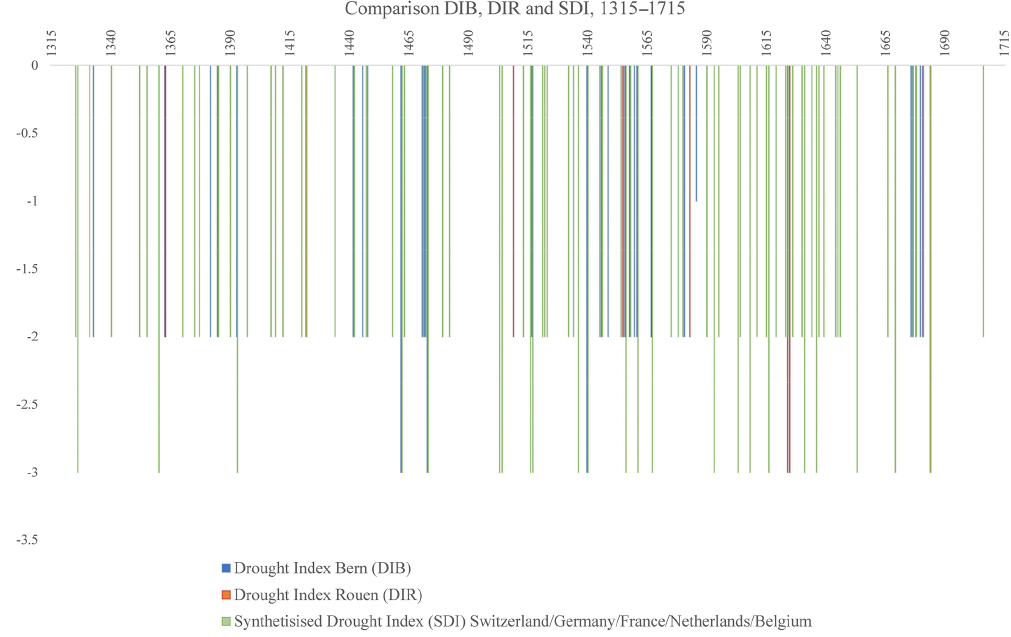
Figure 3. Comparison of the drought index of Bern (DIB) and the drought index of Rouen (DIR) with the synthesised drought index (SDI) for Switzerland, Germany, France, the Netherlands, and Belgium